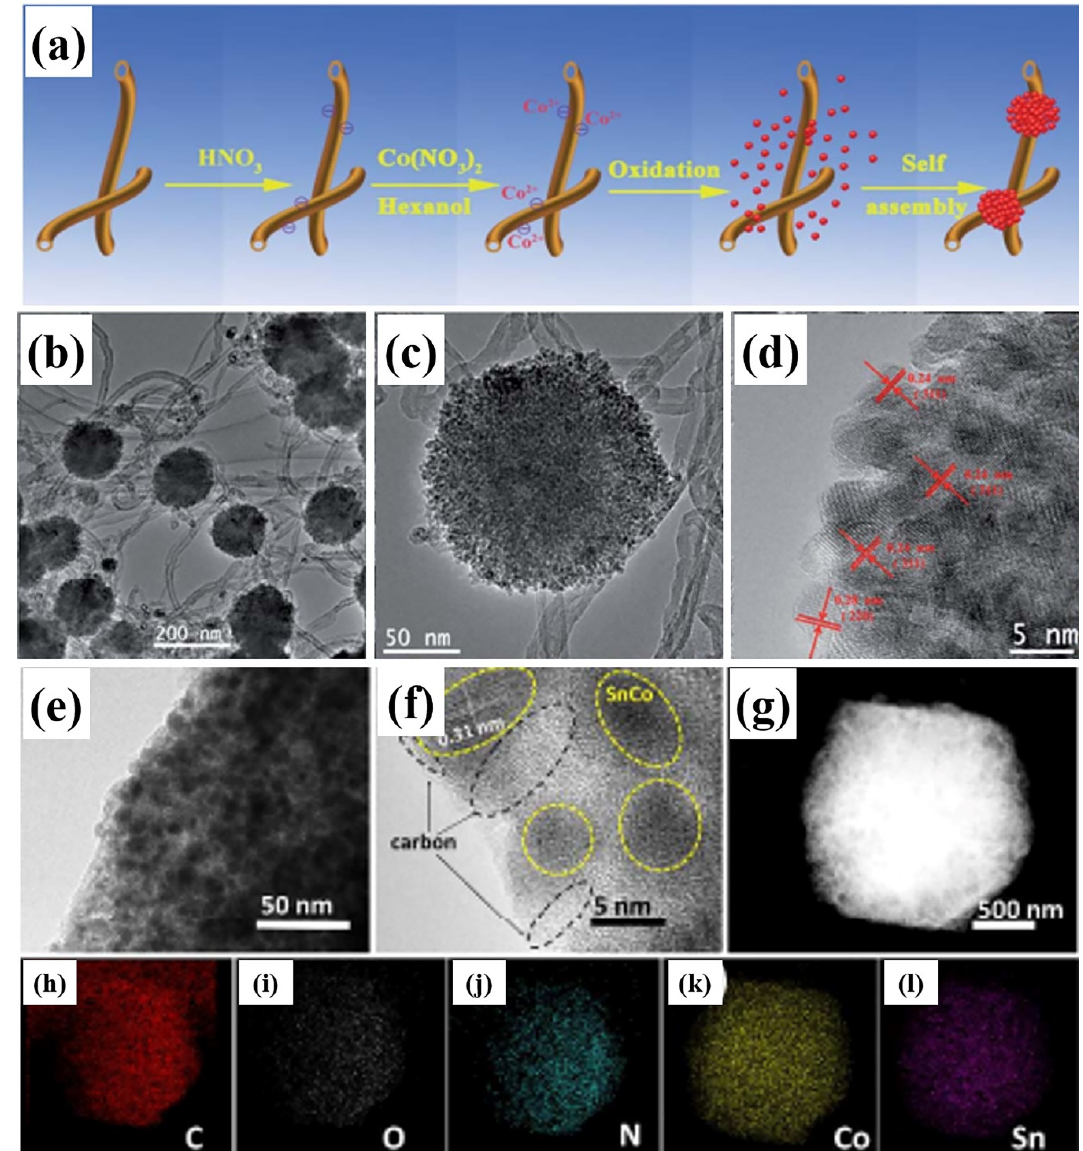
Figure 5. Morphology characterization of cobalt-based composites. ( a ) Schematic evolution of the Co 3 O 4 @CNT composites. TEM images ( b , c ) and HRTEM image ( d ) of the Co 3 O 4 @CNT composites [63]. TEM ( e ) and HRTEM ( f ) images of Sn-Co@C-2; STEM image ( h ) and corresponding elemental